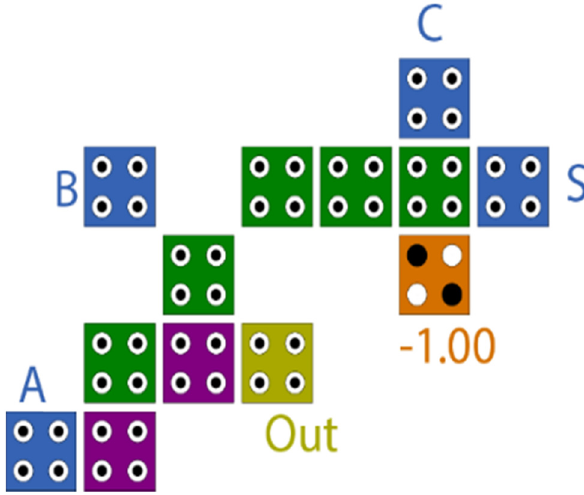
Figure 10: The QCA layout of the proposed gate.